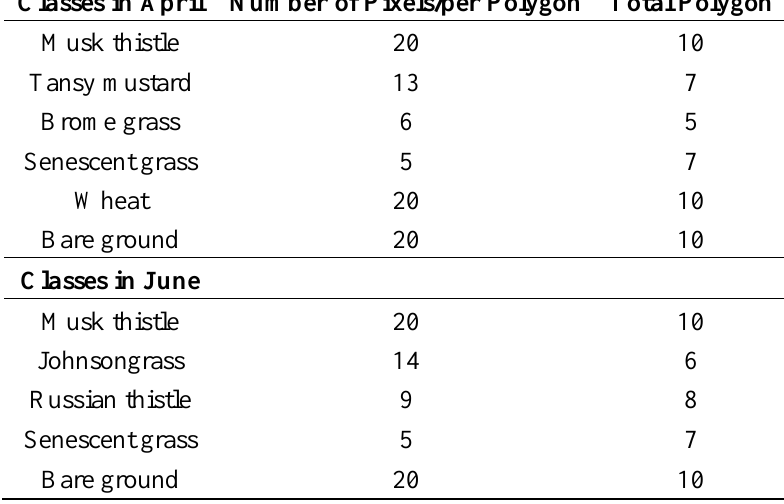
Table 2. Summary of training samples used to extract spectral signatures and classify land cover classes in images taken over the study site near the city of Friona, TX, USA in April and June 2006.